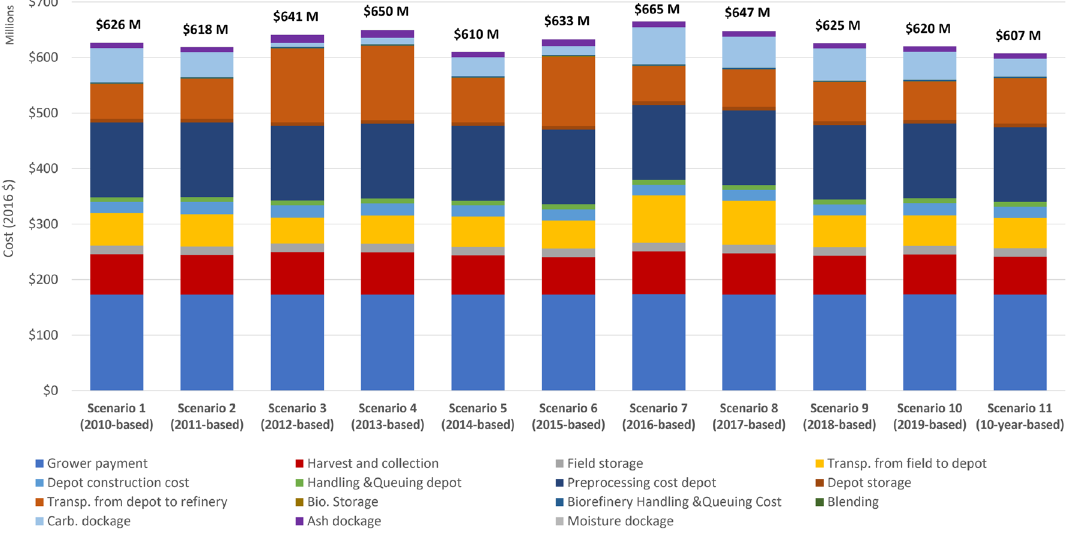
Figure 4. Total cost if depot location, size and quantity are decided based on single year variability or multi- year